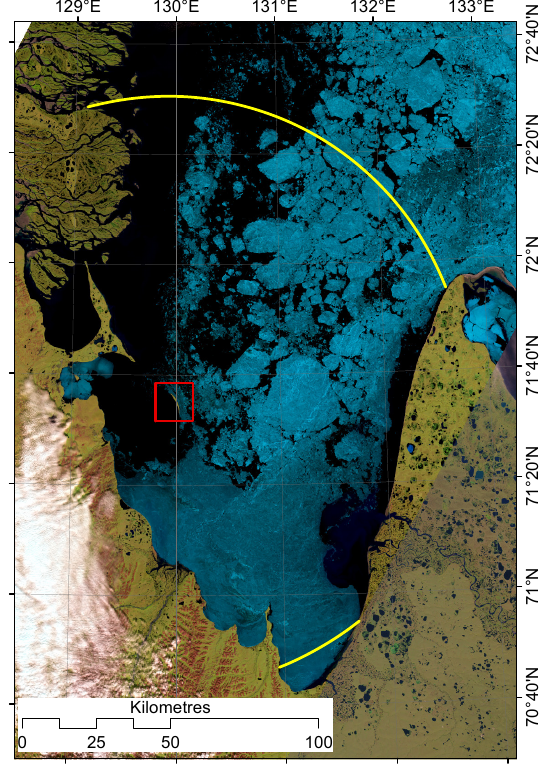
Figure 6. Detail of a Landsat-8 image (5,4,2CIR) showing sea ice break-up around Muostakh Island (red square, size corresponds to one 12.5km SSM/I Pixel) on 18 July 2013. The open water fraction on this day, 100km around Muostakh (yellow circle), was 20%.